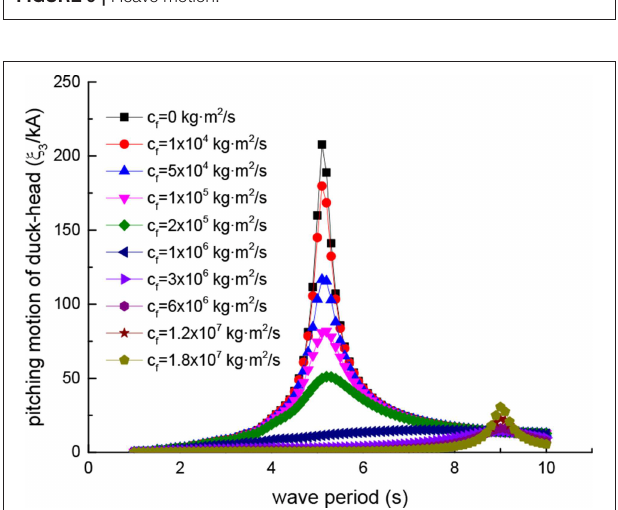
FIGURE 8 | Surge motion. FIGURE 9 | Heave motion.